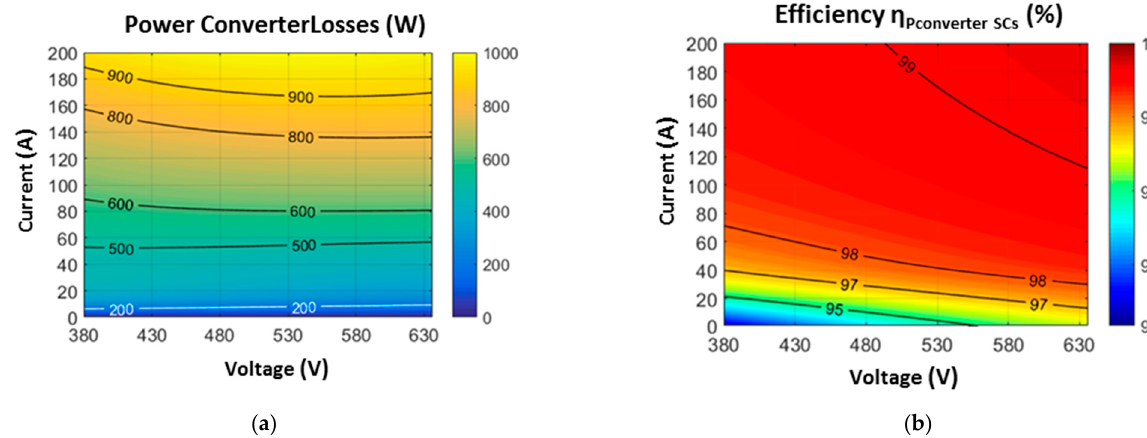
Figure 8. ( a ) Power losses map in the DC/DC converter as a function of the current and voltage in the SCESS module and ( b ) efficiency map in the DC/DC converter as a function of the current and voltage in the SCESS module.